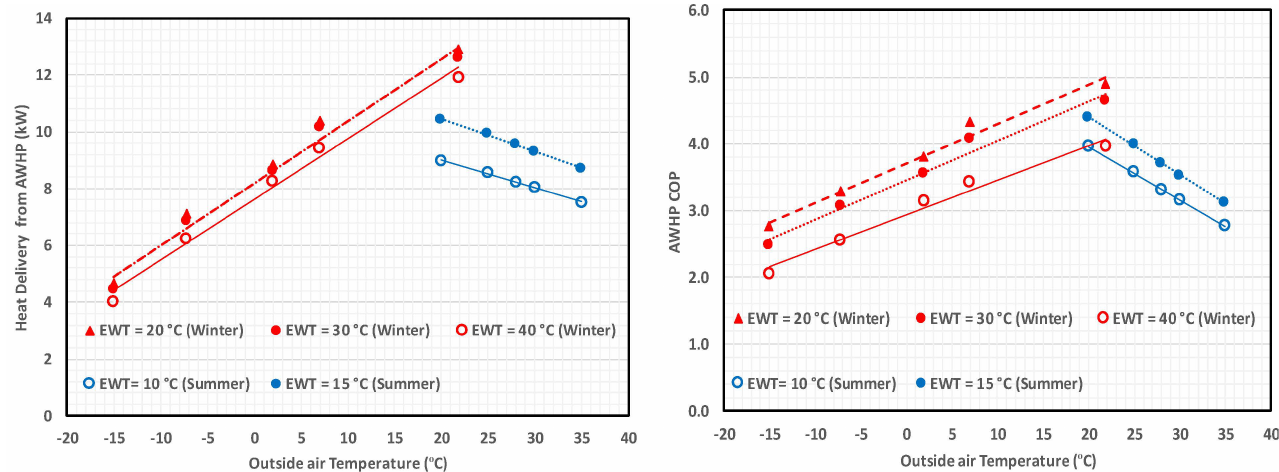
Figure 4. AWHP heat delivery and COP at different outside temperatures and inlet water tempera- tures in winter and summer seasons ( a ) Heat Delivery and ( b )